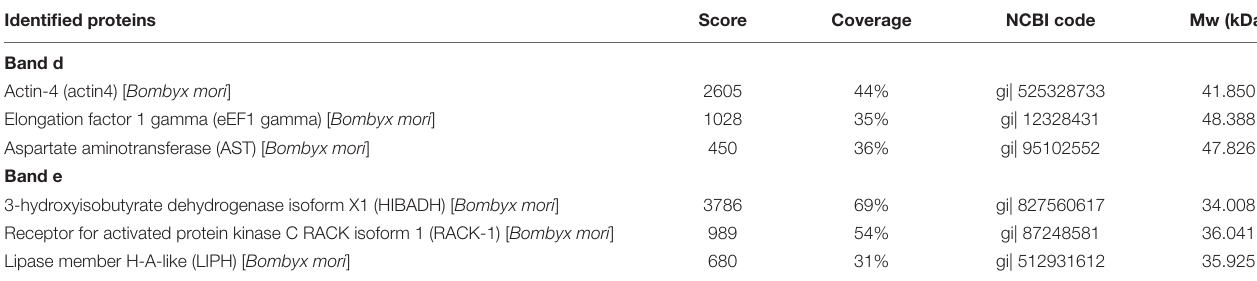
TABLE 3 | Identification of BmNPV-binding proteins in B. mori midgut microsomes separated by SDS-PAGE and identified by LC-MS/MS. Identified proteins Score